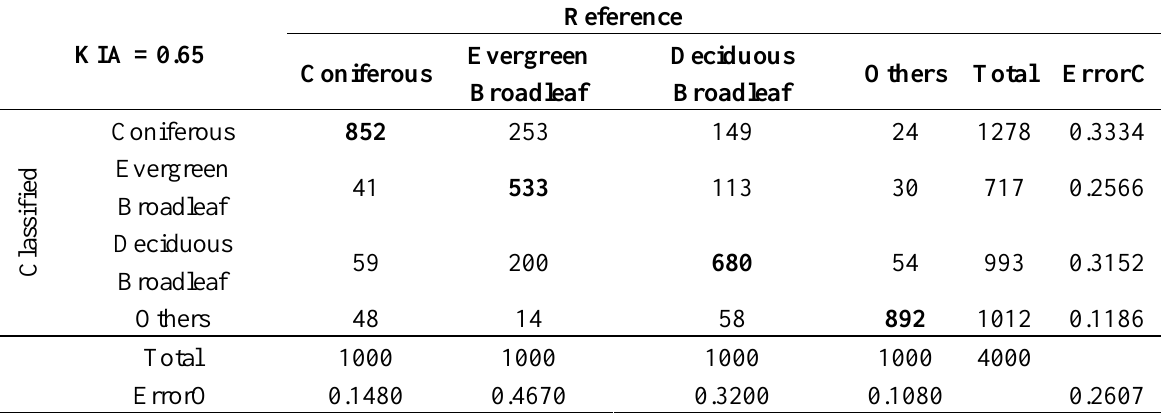
Table 2. Error Matrix showing the reference data (ground truth) versus the image classification. Overall accuracy shows approximately 74% and Kappa Index of Agreement (KIA) as 0.65. Reference KIA = 0.65